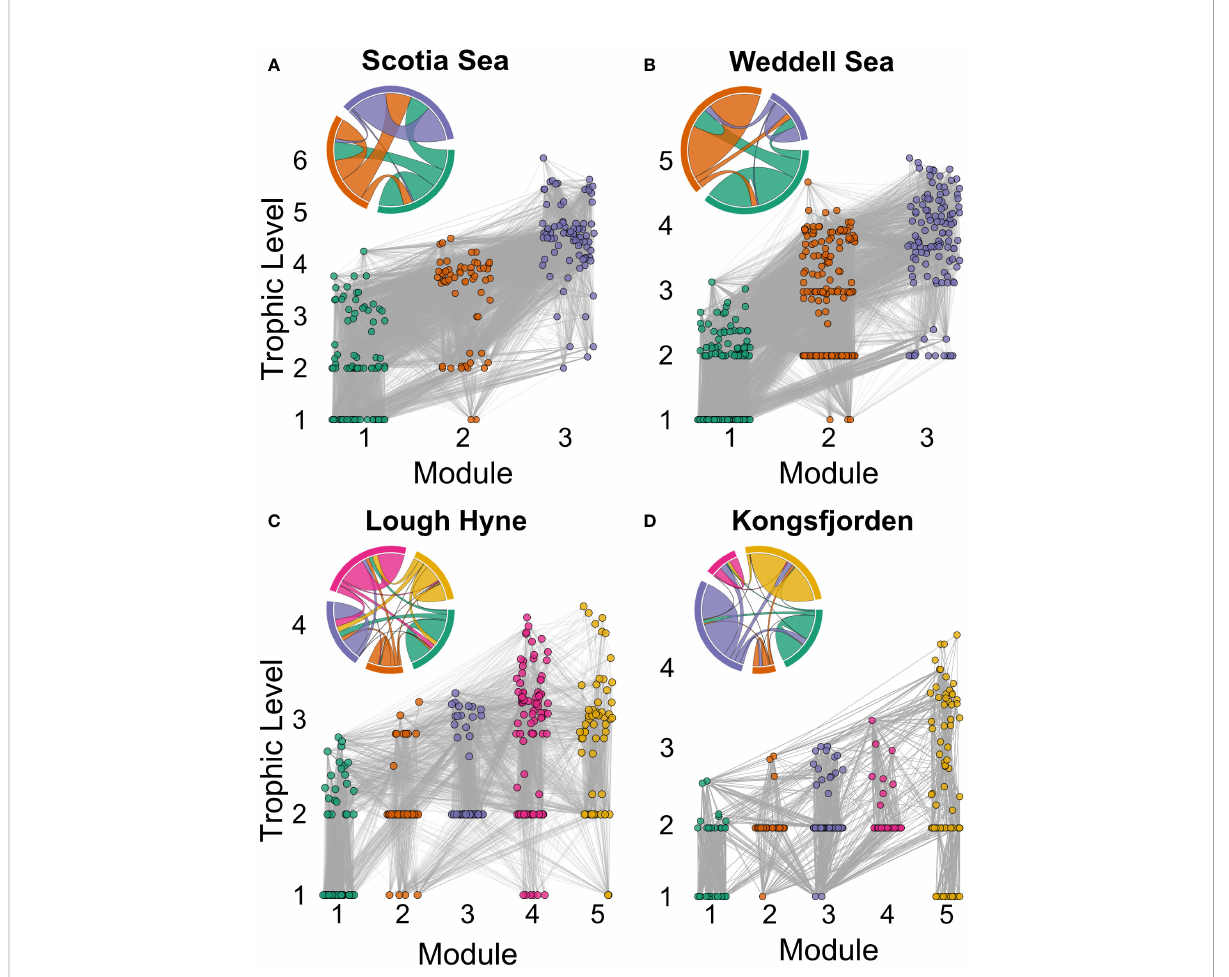
FIGURE 2 Modular structure of the four studied food webs: (A) Scotia Sea; (B) Weddell Sea; (C) Lough Hyne; (D) Kongsfjorden. Networks are plotted with nodes coloured and positioned along the x- and y-axes according to module and trophic level, respectively. Inset chord diagrams display the distribution of interactions within and between modules, with chord thickness proportional to the number of links and colour indicating the source module of the